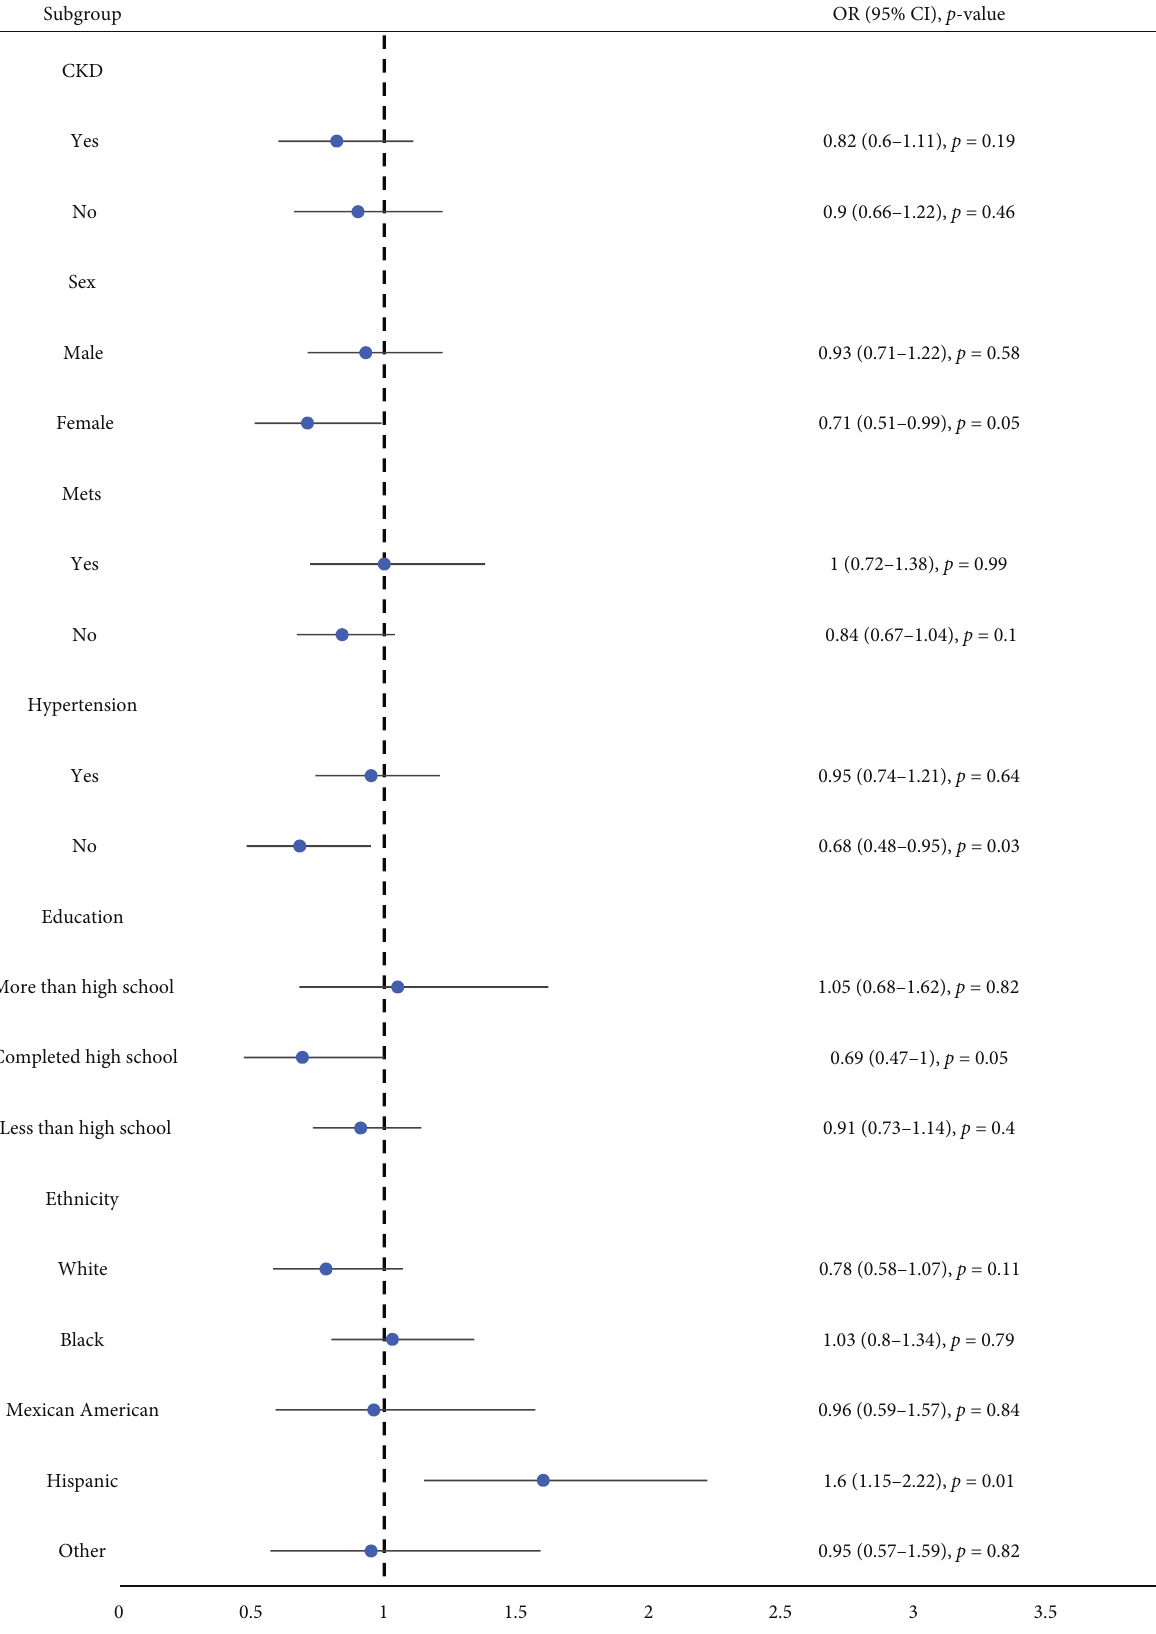
Figure 3: Subgroup analysis of risk factors for the relationship between AI and cognitive impairment. In the subgroup analysis strati fi ed by age, gender, race, the education level, and diagnosis of CKD, MetS, and hypertension, the model is not adjusted for sex, race, education level, CKD, hypertension, and MetS,